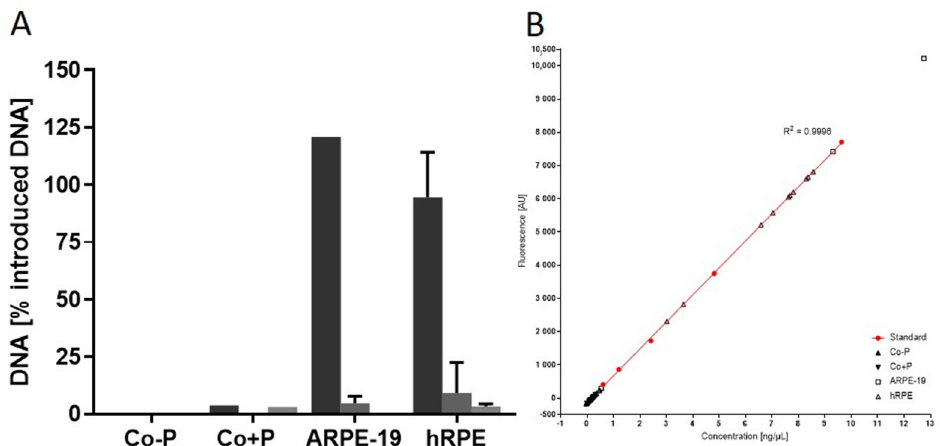
Figure 2. Recovery of DNA in the supernatant of centrifuged transfected cells. ( A ) Cultured hRPE and ARPE-19 cells, transfected with the PEDF-plasmid construct were centrifuged 3 times and the DNA in the supernatant determined. Two controls were analyzed: hRPE cells not electroporated nor mixed with DNA (Co-P), hRPE cells electroporated without addition of DNA (Co+P) cells. Only after electroporation DNA was detected in the supernatant. In both groups of transfected cells, the majority of introduced DNA was recovered after 1 centrifugation (ARPE-19: 120.82%; hRPE: 94.6 ± 19.6%). After the second and third centrifugations, only small amounts of DNA were detected and only in some samples. Second centrifugation: ARPE-19 = 4.8 ± 3.0% (n = 2); hRPE = 9.3 ± 13.2% (n = 7). Third centrifugation: hRPE = 3.4 ± 1.1% (n = 3). ( B ) Standard curve for DNA quantification. n = 2 (Co-P, Co+P, ARPE-19) and n = 9